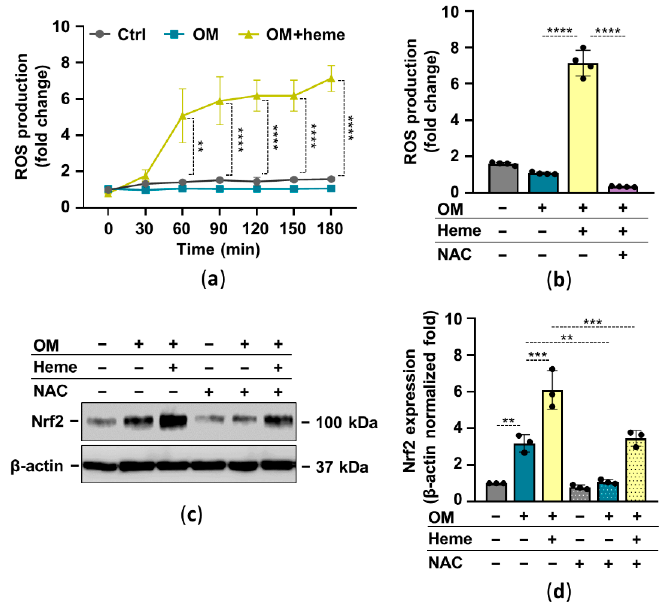
tween Nrf2 and oxidative stress in which ROS activates Nrf2 and Nrf2 target genes control